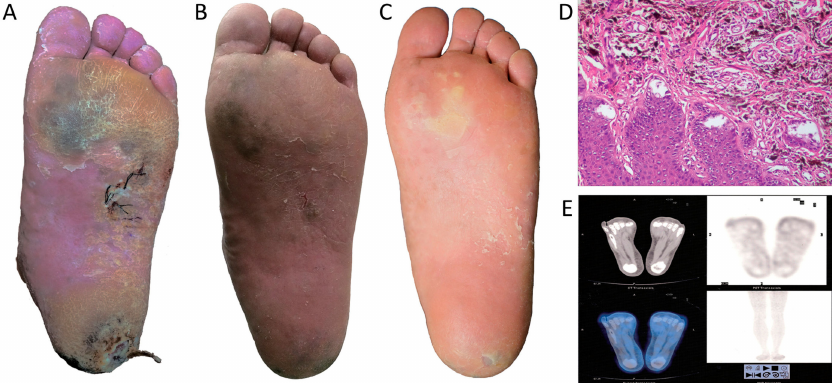
Figure 10. Gross examination of the skin lesions in the patient’s left foot 2 weeks ( A ), 5 weeks ( B ) and 24 months ( C ) after BNCT; ( D ) Pathological analysis after BNCT; ( E ) PET / CT scan after BNCT (reprint from Ref.